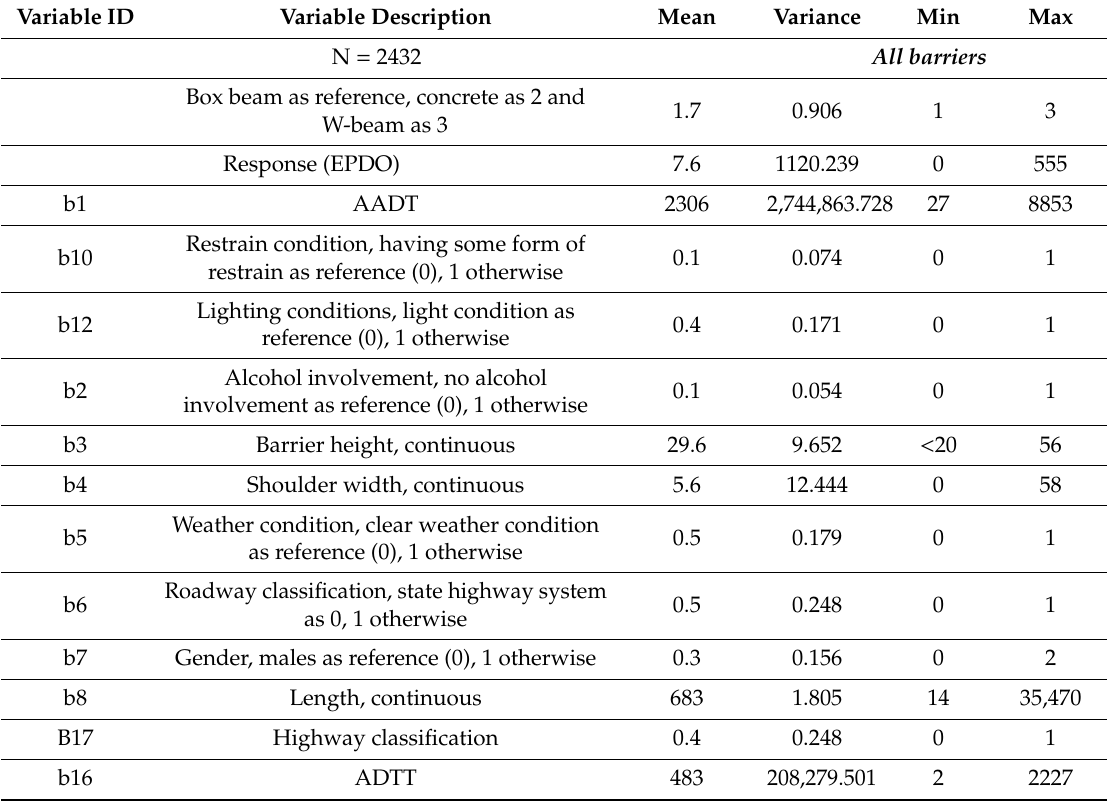
Table 1. Summary statistics of important predictors: the whole data being used for training.